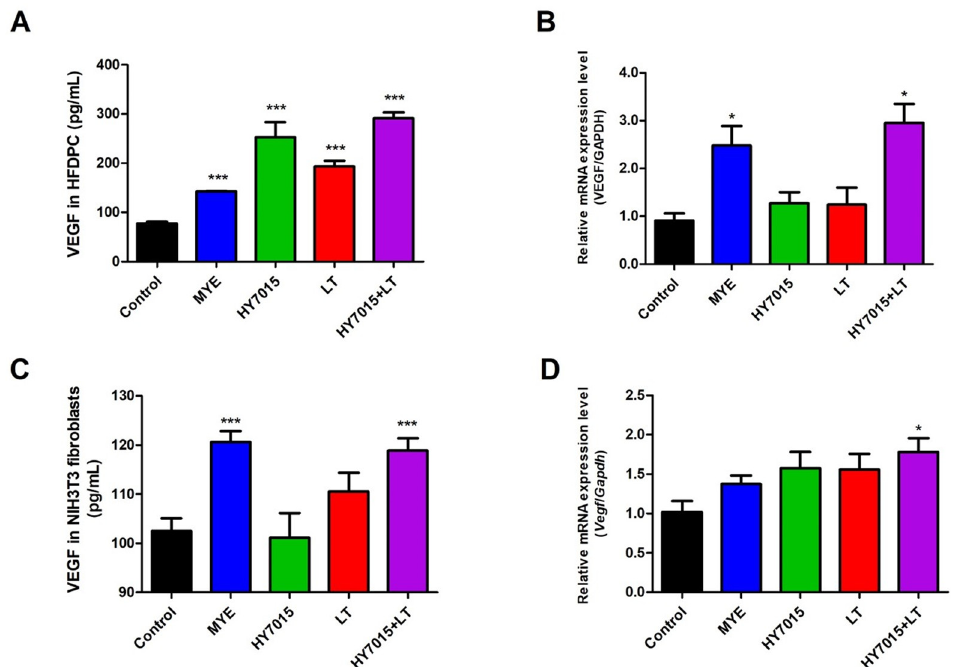
Figure 3. Effect of Lactobacillus paracasei HY7015 (HY7015) and/or Lycopus lucidus Turcz. (LT) extract on VEGF proteins ( A ) and mRNA ( B ) of HFPDC, VEGF proteins ( C ), and Vegf mRNA ( D ) of NIH3T3 fibroblasts. Protein levels of VEGF were measured by ELISA kit. Relative mRNA levels of VEGF were monitored by qPCR and normalized against GAPDH. Data are presented as mean ± SE. Significant differences are indicated by * p < 0.05 and *** p < 0.001, relative to the control group. SE, standard error; VEGF, vascular endothelial growth factor; MYE, medicinal yeast extract; HY7015, Lactobacillus paracasei HY7015; LT, Lycopus lucidus Turcz.; HY7015+LT, Lactobacillus paracasei HY7015 with Lycopus lucidus Turcz.